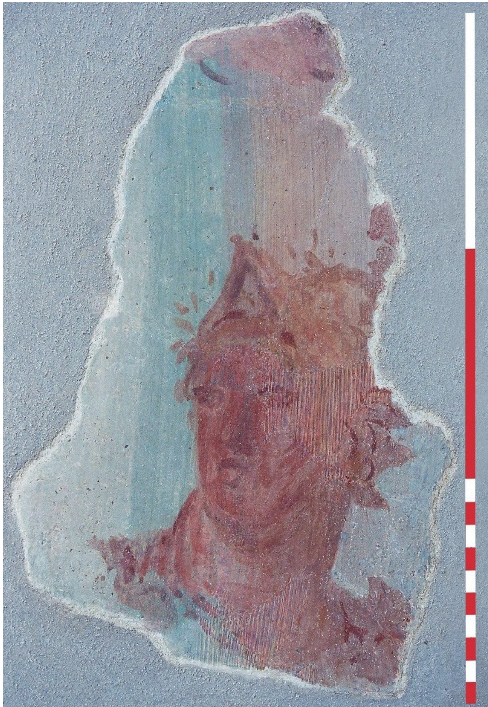
Figure 13. House H10E, representation of a woman in a nautical crown (photo Stanis ł aw Medeksza).